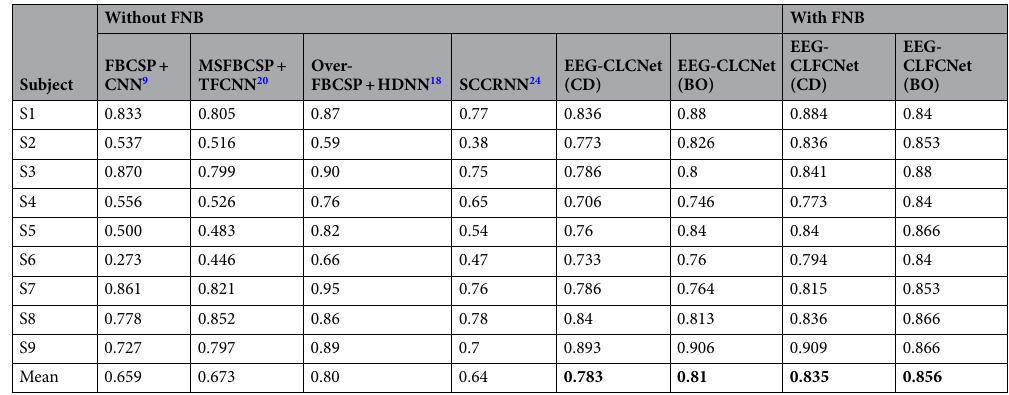
Table 7. Comparison between our networks and previous networks in terms of kappa values. Significant values are in